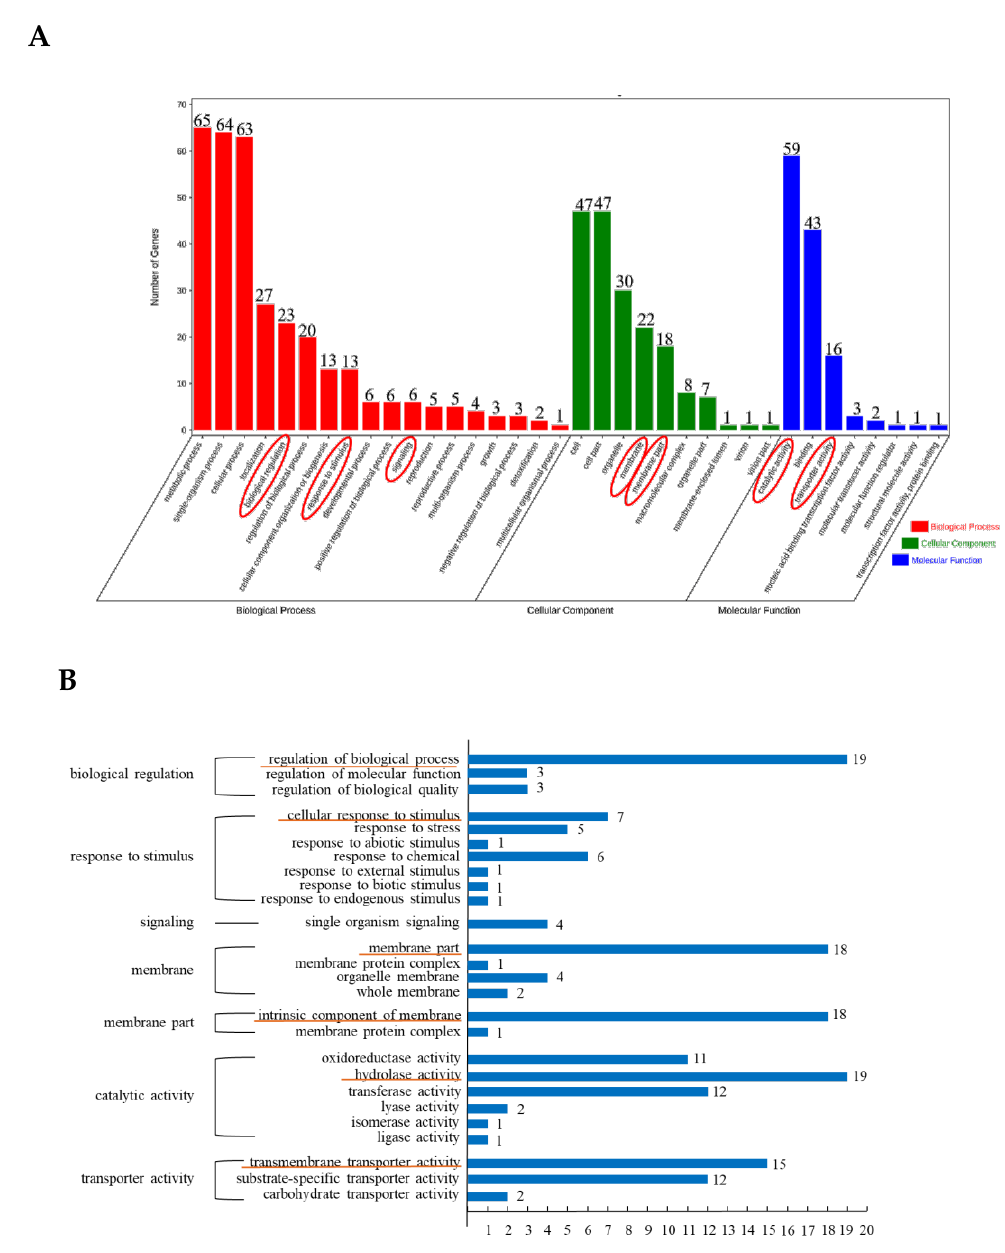
Figure 2. GO secondary ( A ) and tertiary ( B ) enrichment analysis of DEGs in P. expansum. The red circle in ( A ) and the yellow underline in ( B ) are GO secondary term and tertiary term related to infection.